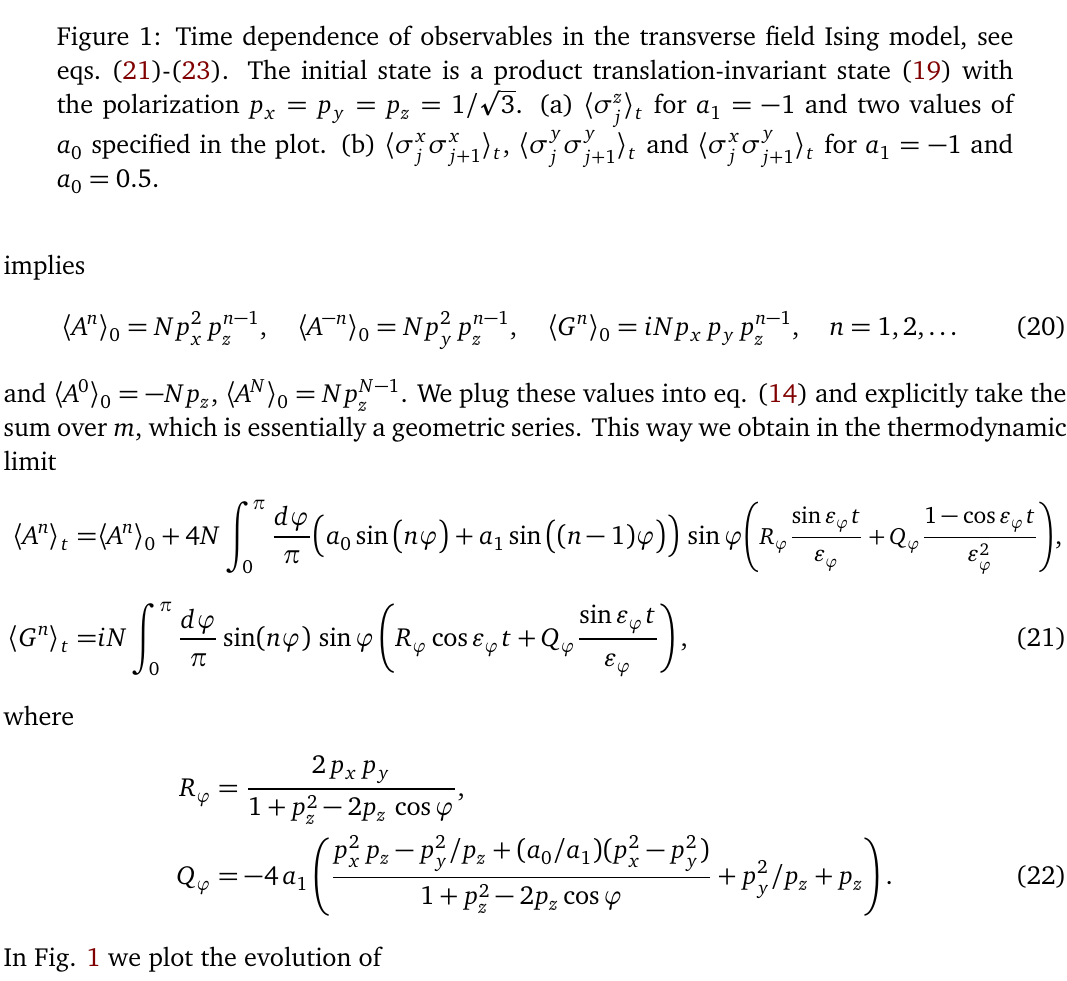
(cid:112) = p = p = 1 / 〉 = − 1 and two values of 3. (a) 〈 σ z for a x y z t 1 j σ x 〉 σ y 〉 σ y 〉 = − 1 and , 〈 σ y and 〈 σ x for a t t t 1 j j + 1 j j j + 1 j + 1